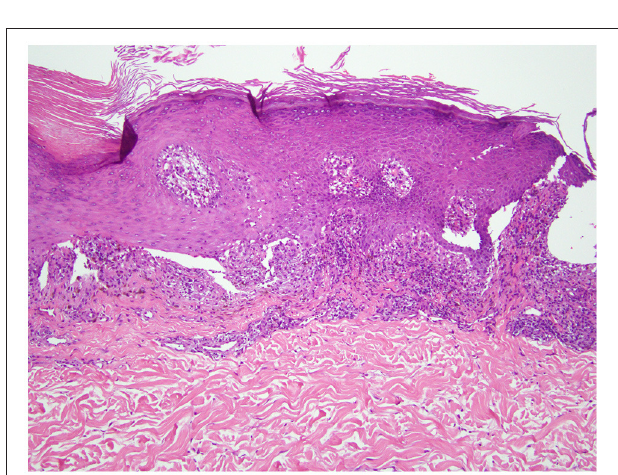
FIGURE 2 | Punch biopsy of a representative lesion (left upper arm). Hematoxylin and eosin staining revealed an acanthotic epidermis with hyperkeratosis and hypergranulosis. There is a band-like lymphohistiocytic infiltrate at the dermal-epidermal junction with focal squamatization of the basal cell layer and scattered necrotic keratinocytes (20 ×